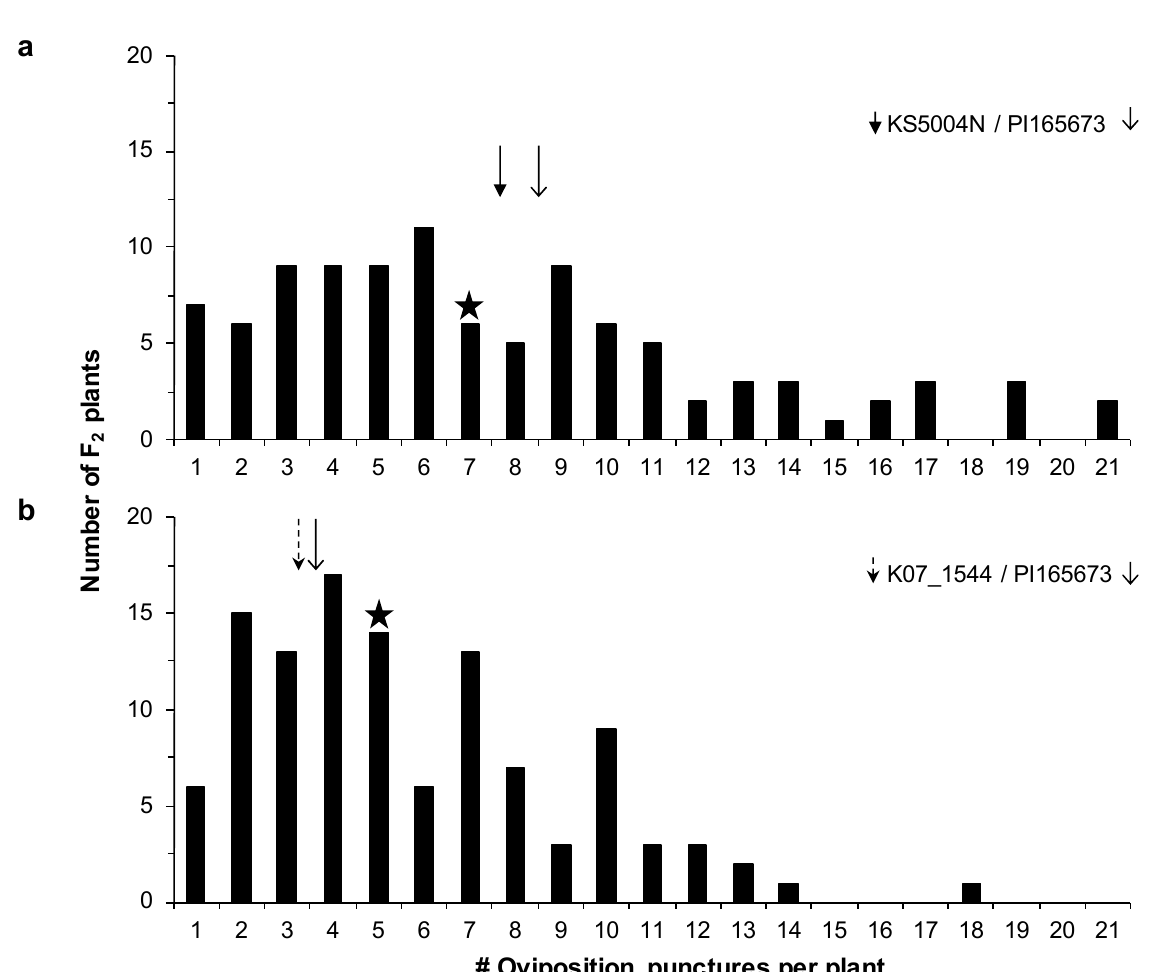
Figure 2. Frequency distributions of number of oviposition punctures per plant in F 2 soybean populations ( a ) KS5004N/PI165673 and ( b ) K07-1544/PI165673 at 21 d post infestation with Dectes texanus in 2011. Arrows and stars indicate parent and F 2 means, respectively. Table 2. Mean ± SEM OL antibiosis ratios, numbers of oviposition punctures, and numbers of larvae per plant in soybean genotypes K07-1544 and PI165673 at 21 d post infestation with Dectes texanus in 2012.